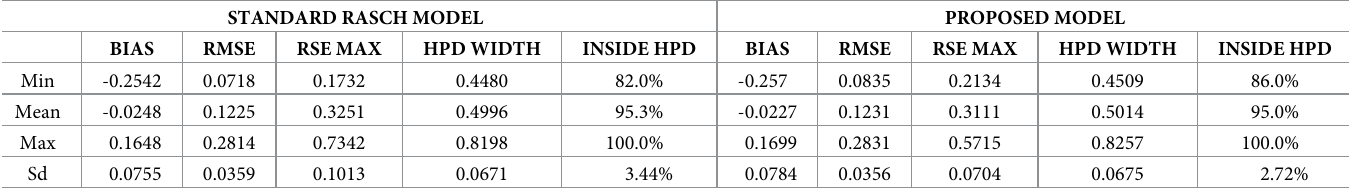
Table 4. Summary of the estimated parameters in scenario